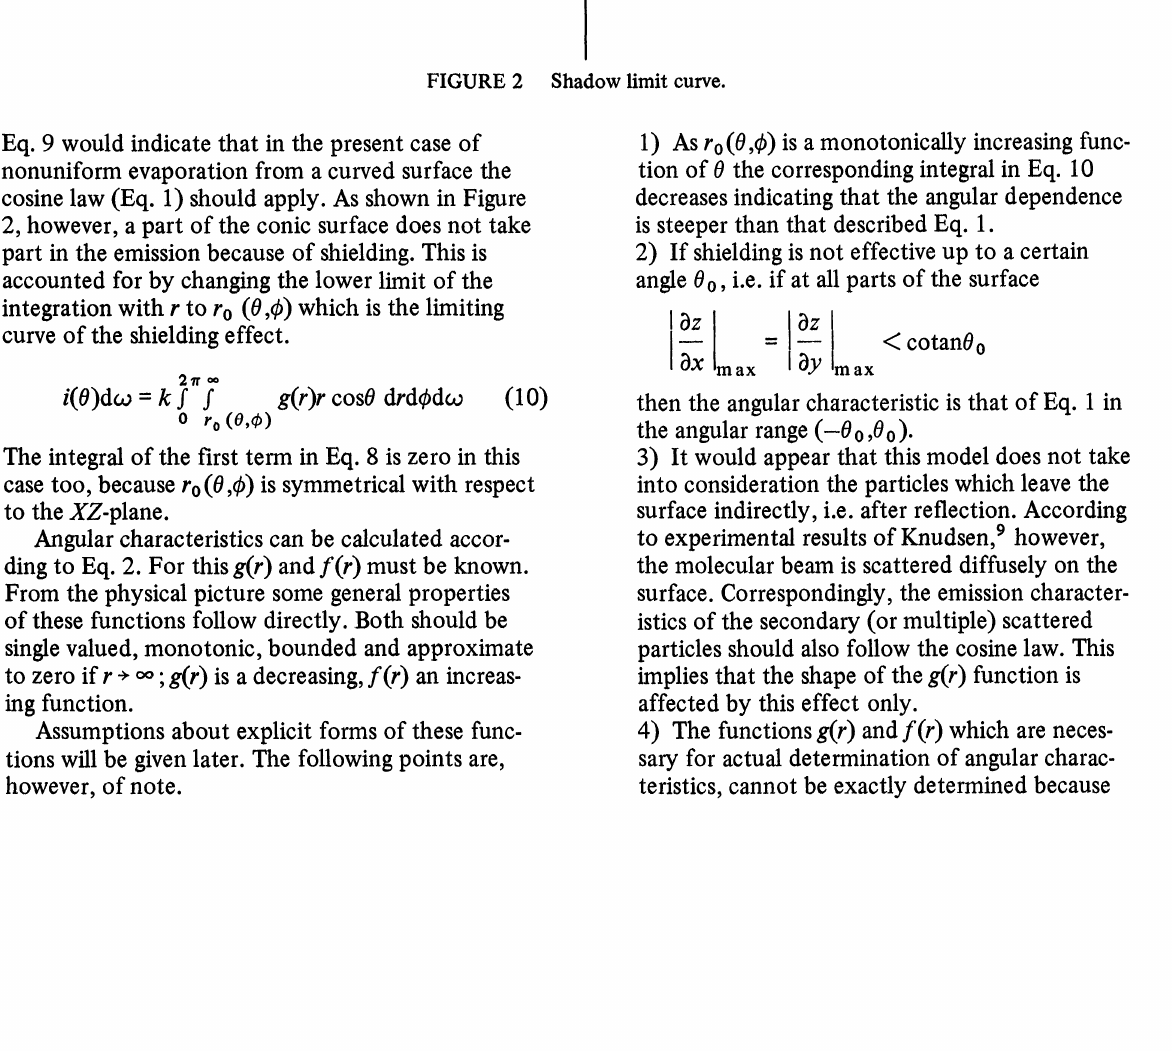
FIGURE 2 Shadow limit